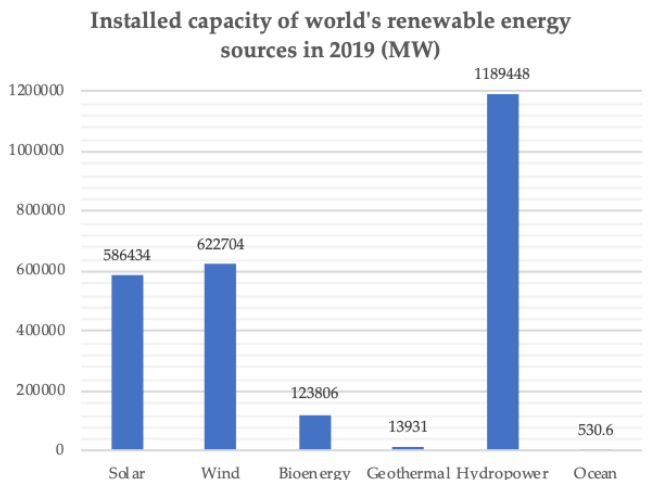
Figure 10. Installed capacity of world ’ s renewable energy in 2019 (Source: IRENA).